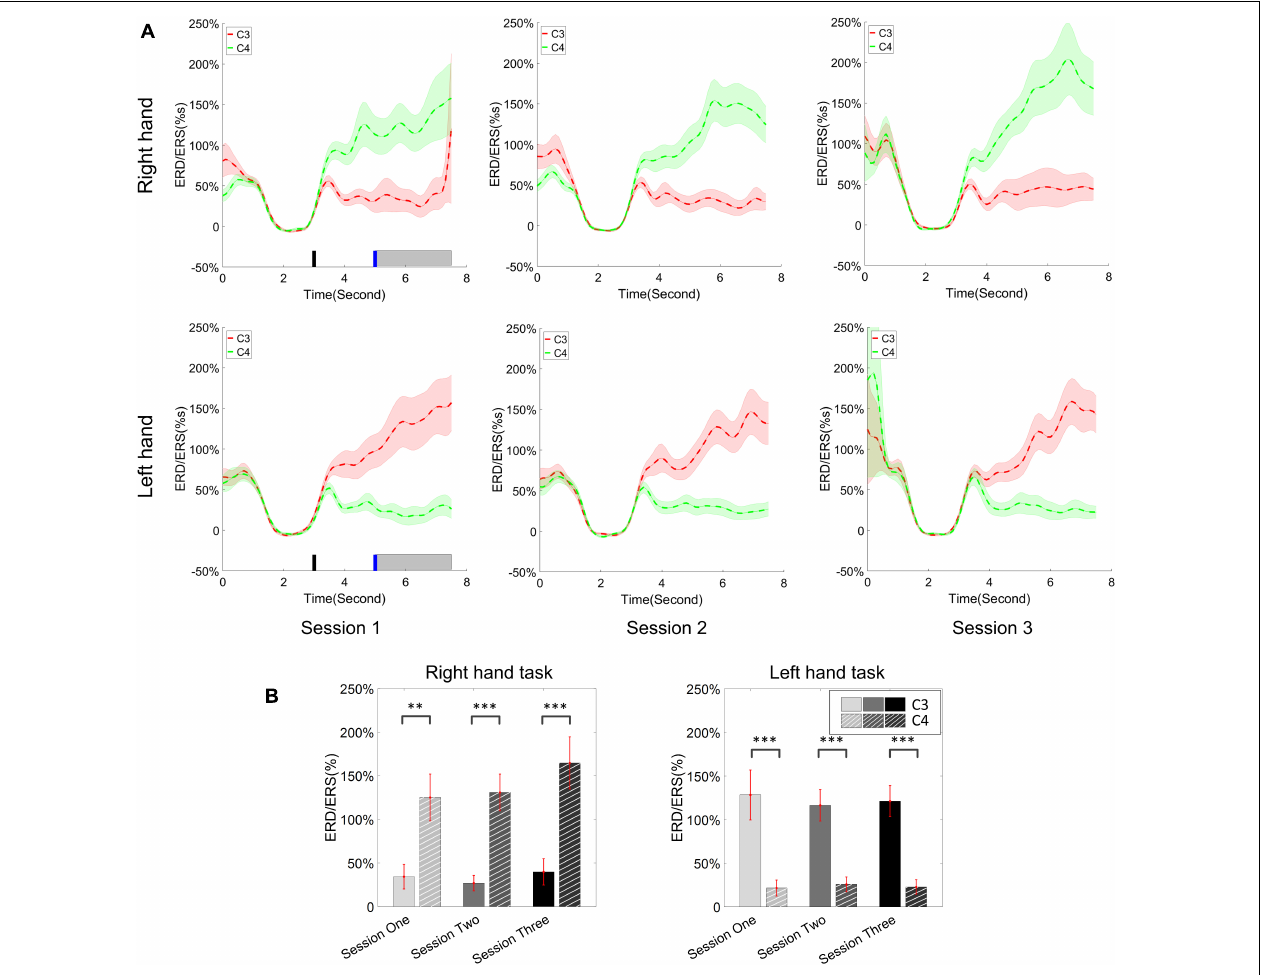
FIGURE 7 | ERD/ERS value and its statistics. Only the hit trials are used for the calculation of ERD/ERS values. (A) The time varying group average of ERD/ERS value for the right hand task (the upper row) and left hand task (the bottom row) across the three training sessions. The target cue appeared at the end of second 3 and the cursor feedback began at the end of second 5. (B) The grand average ERD/ERS values during the period of [5–7.5]s, which was marked in gray bar area in subplot (A) , were compared for right hand tasks and left hand tasks, separately. The statistical analysis showed a significant difference between channel C3 and C4 during each session; no significance was found among the session pairs across the training. ∗∗ p < 0.01, ∗∗∗ p <